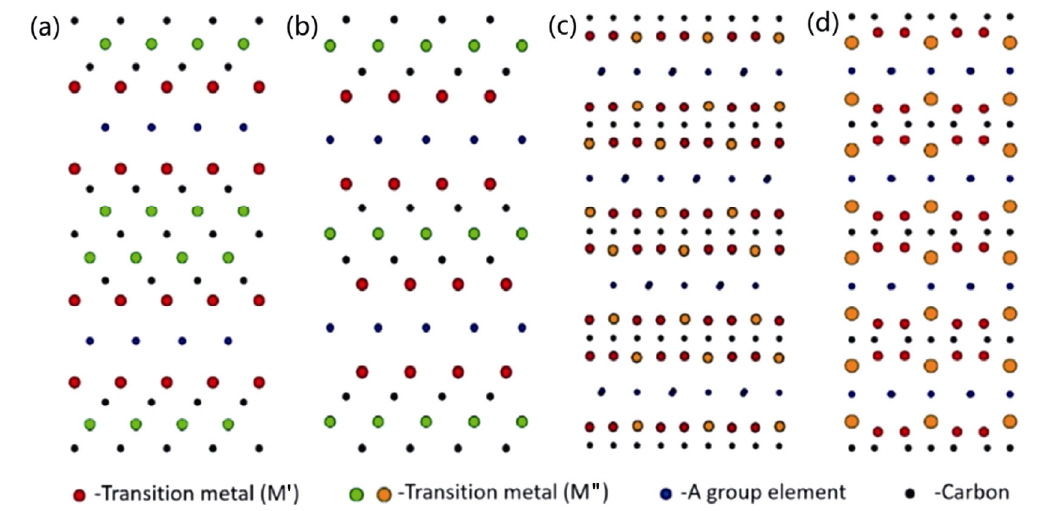
Fig. 3 Schematics of various ordered MAX phases. (a) 413 o-MAX, (b) 312 o-MAX, (c) C 2/ c space group i-MAX, and (d) Cmcm space group i-MAX. Reproduced with permission from Ref. [31], © Elsevier Inc.